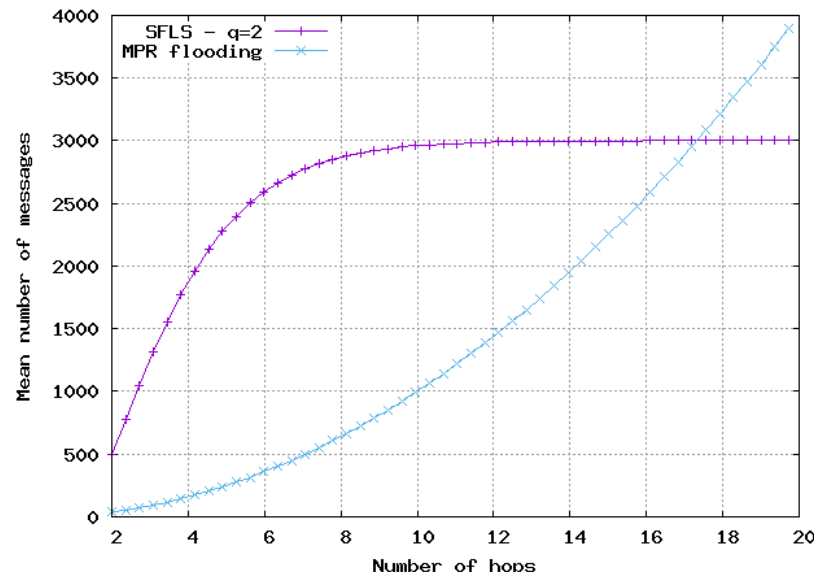
Figure 11. Mean number of messages sent for update with respect to number of hops in 2D homogeneous network, M = 1000. Comparison of SFLS with MPR